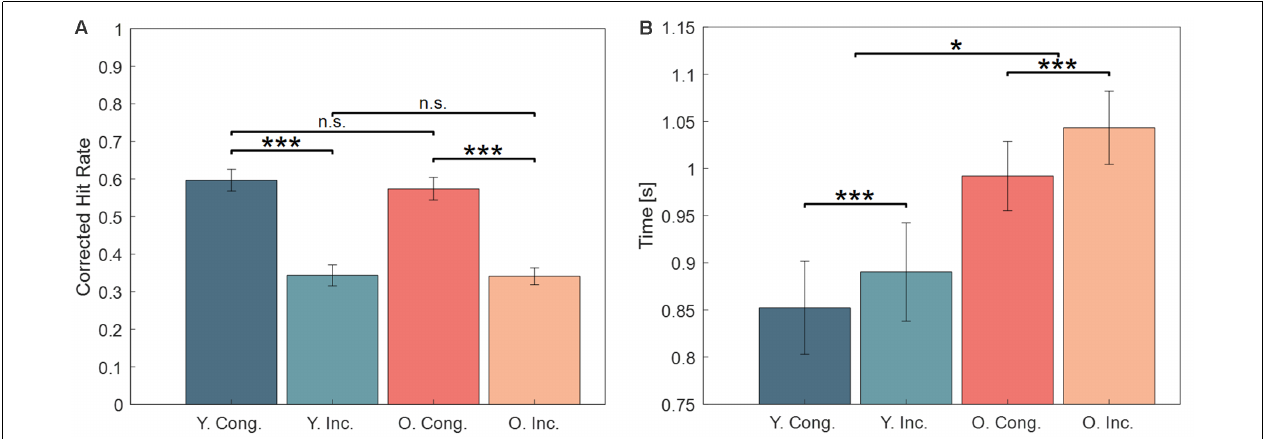
FIGURE 2 | (A) Behavioral results. Memory performance was significantly higher for congruent items in both age groups. (B) Reaction Times (RT) during recognition of congruent and incongruent items. Correctly responding to incongruent items took longer in both groups, and older participants had overall slower RTs. Error bars show one Standard Error of the Mean (SEM). Abbreviations: Y., young, O., older, Cong., congruent, Inc., incongruent, n.s., not significant. ***Indicates statistical significance at p < 0.001 and * p <